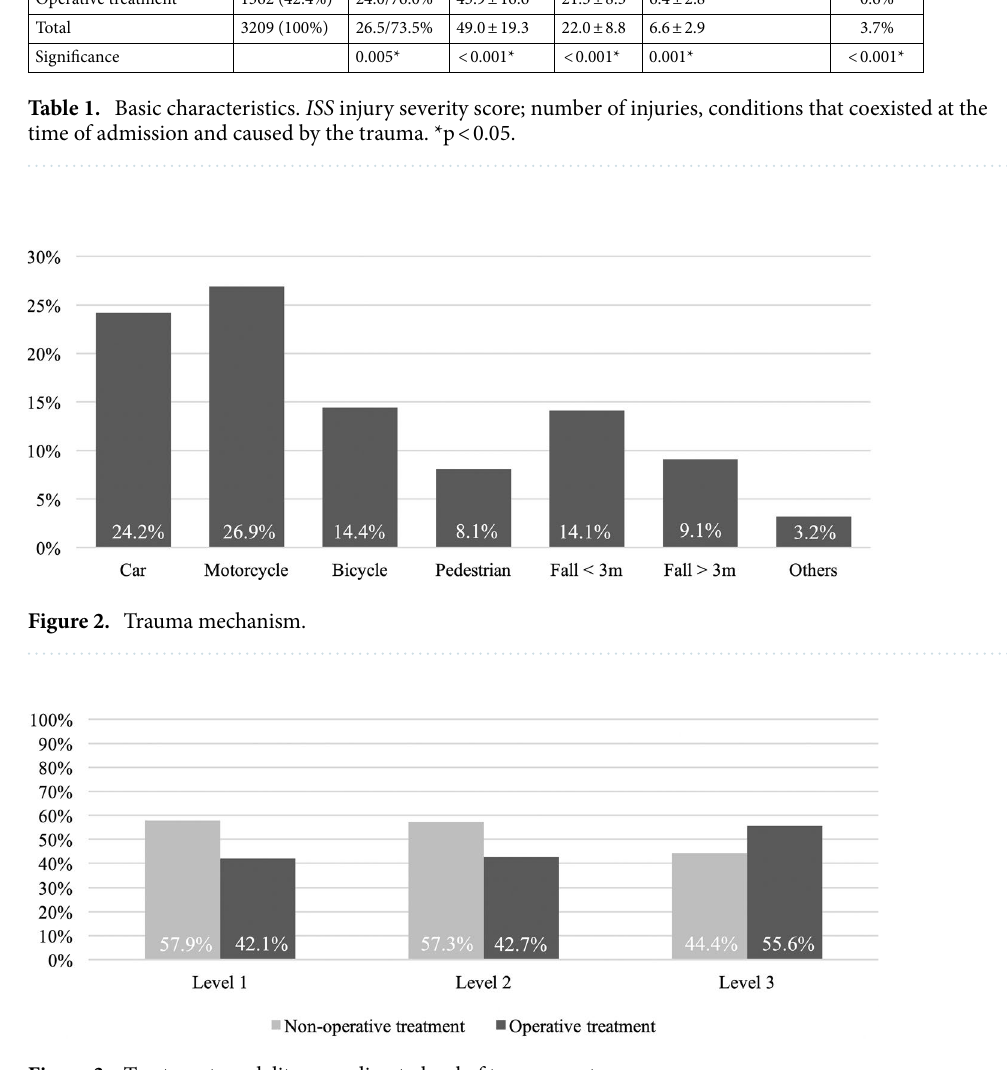
Figure 3. Treatment modality according to level of trauma